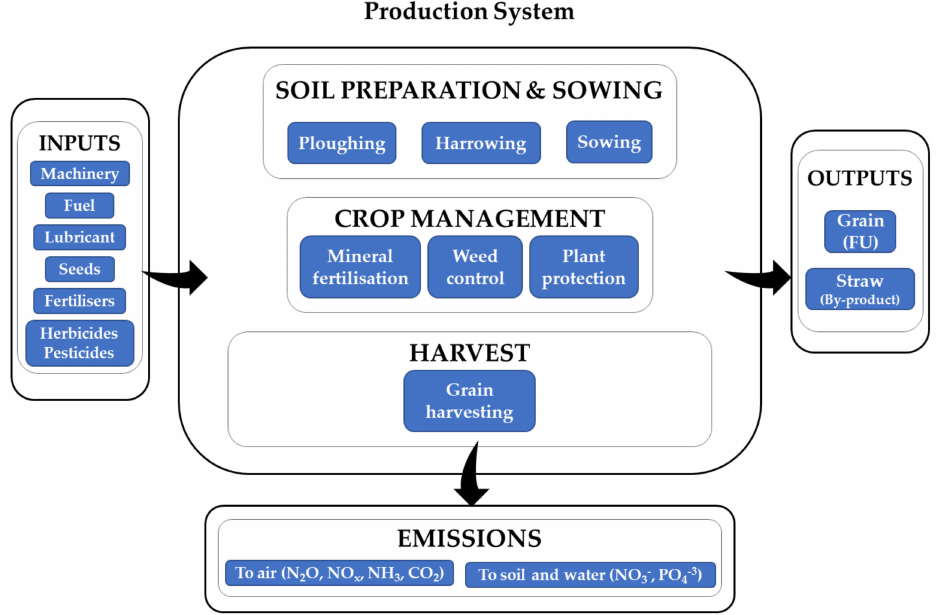
Figure 2. Inputs and processes, according to life cycle stages, for the barley production system analysed